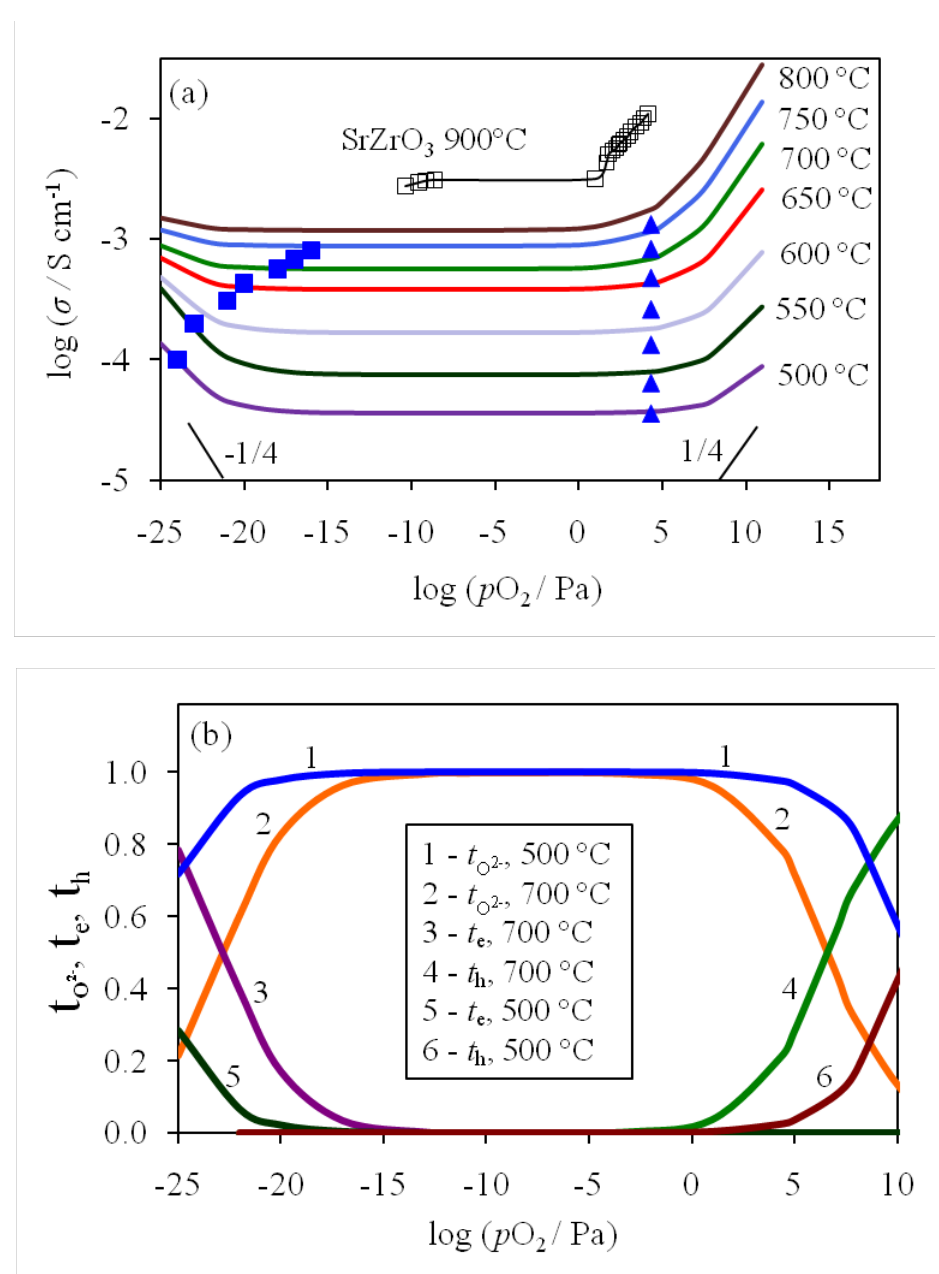
Figure 9. Calculated ( a ) total conductivity and ( b ) transport numbers of oxygen ions, electrons and holes in SZY as functions of p O 2 . Closed squares and triangles show the total conductivity of the bulk SZY sample in wet hydrogen and wet air, respectively, obtained from impedance data. Open squares show the conductivity data for SrZrO 3 reported in [43].